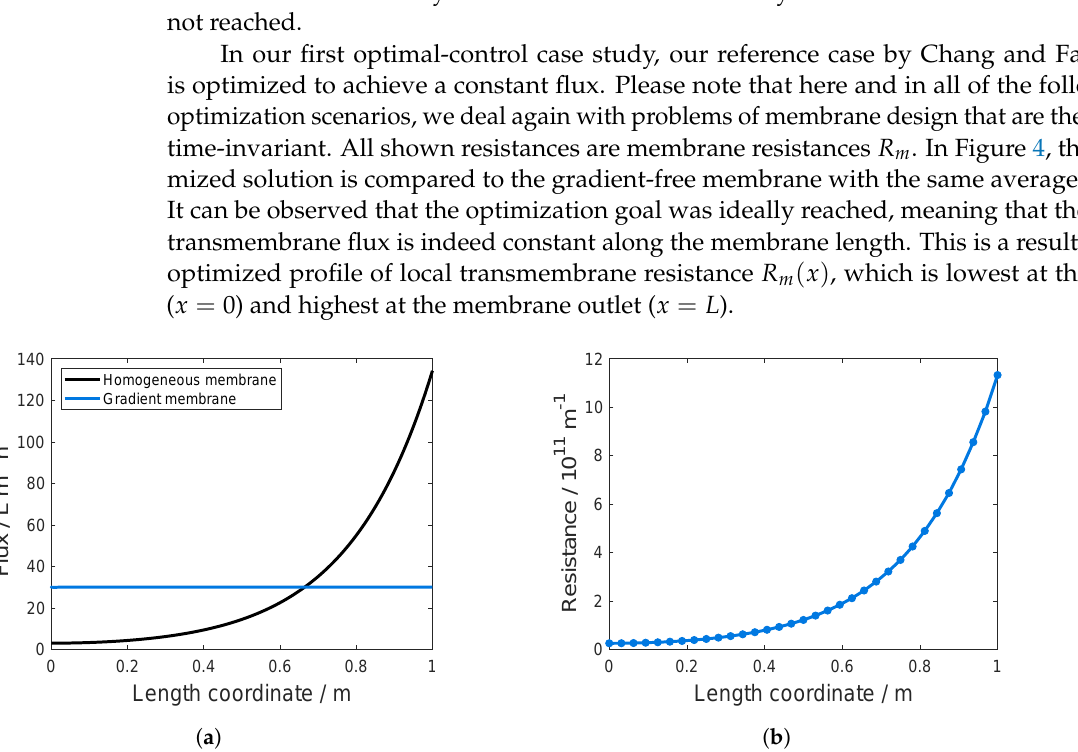
Figure 4. Optimization of reference case; flux profiles J ( x ) ( a ) and optimized resistance profile R m ( x ) ( b ).